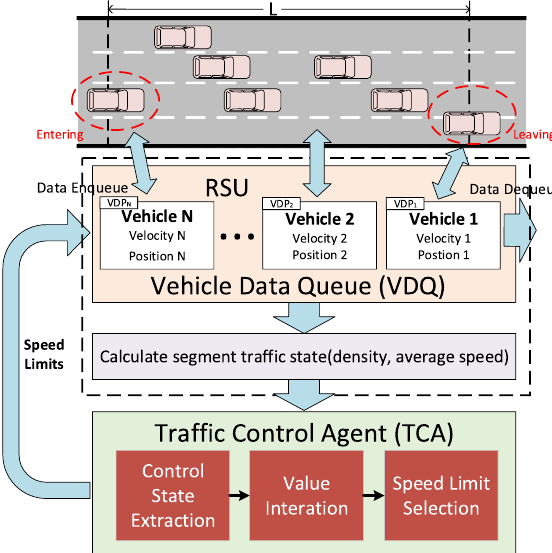
Figure 3. Scheme of traffic state collection and speed limit executing process